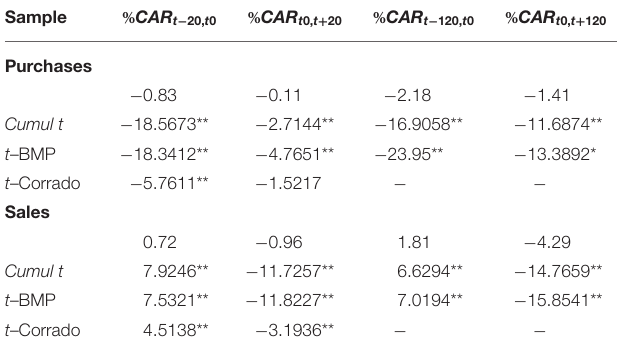
TABLE 2 | Medium-term abnormal returns. TABLE 3 | CAR with Scholes and Williams (1977) thin trading adjustment.